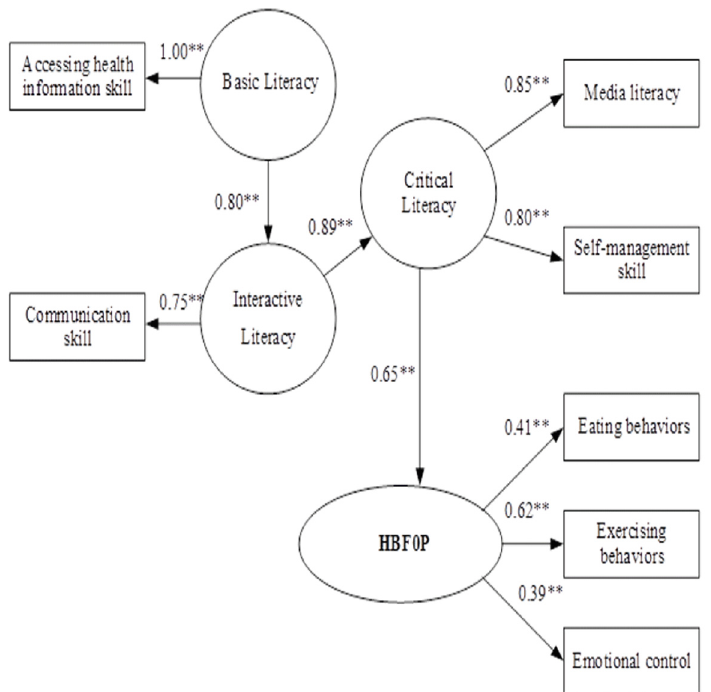
Figure 4. The causal model of health literacy on health behavior for obesity prevention among primary school students in Bangkok, Thailand. Chi-Square = 13.68, df = 7, P-value = 0.05721, RMSEA = 0.040, Standardized RMR = 0.017 NFI = 0.99 GFI = 0.99 AGFI =